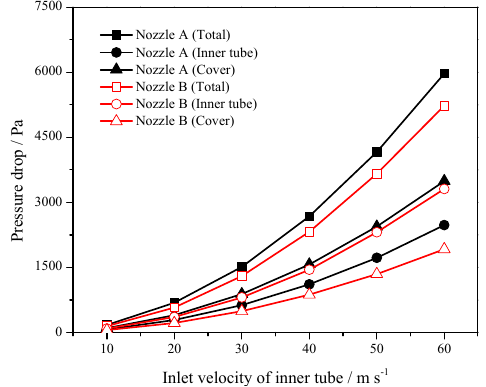
Figure 9. Pressure drop characteristics of nozzle A and nozzle B.